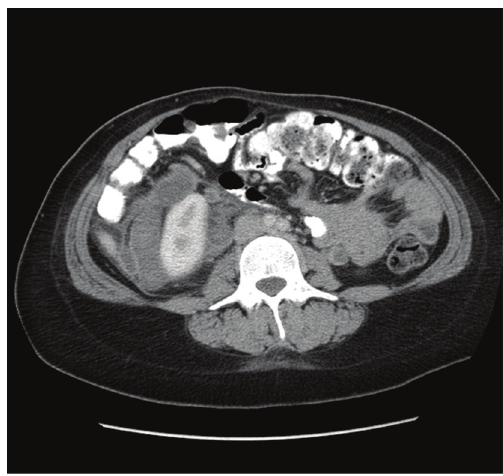
Figure 3: Coronal section right ovarian vein case